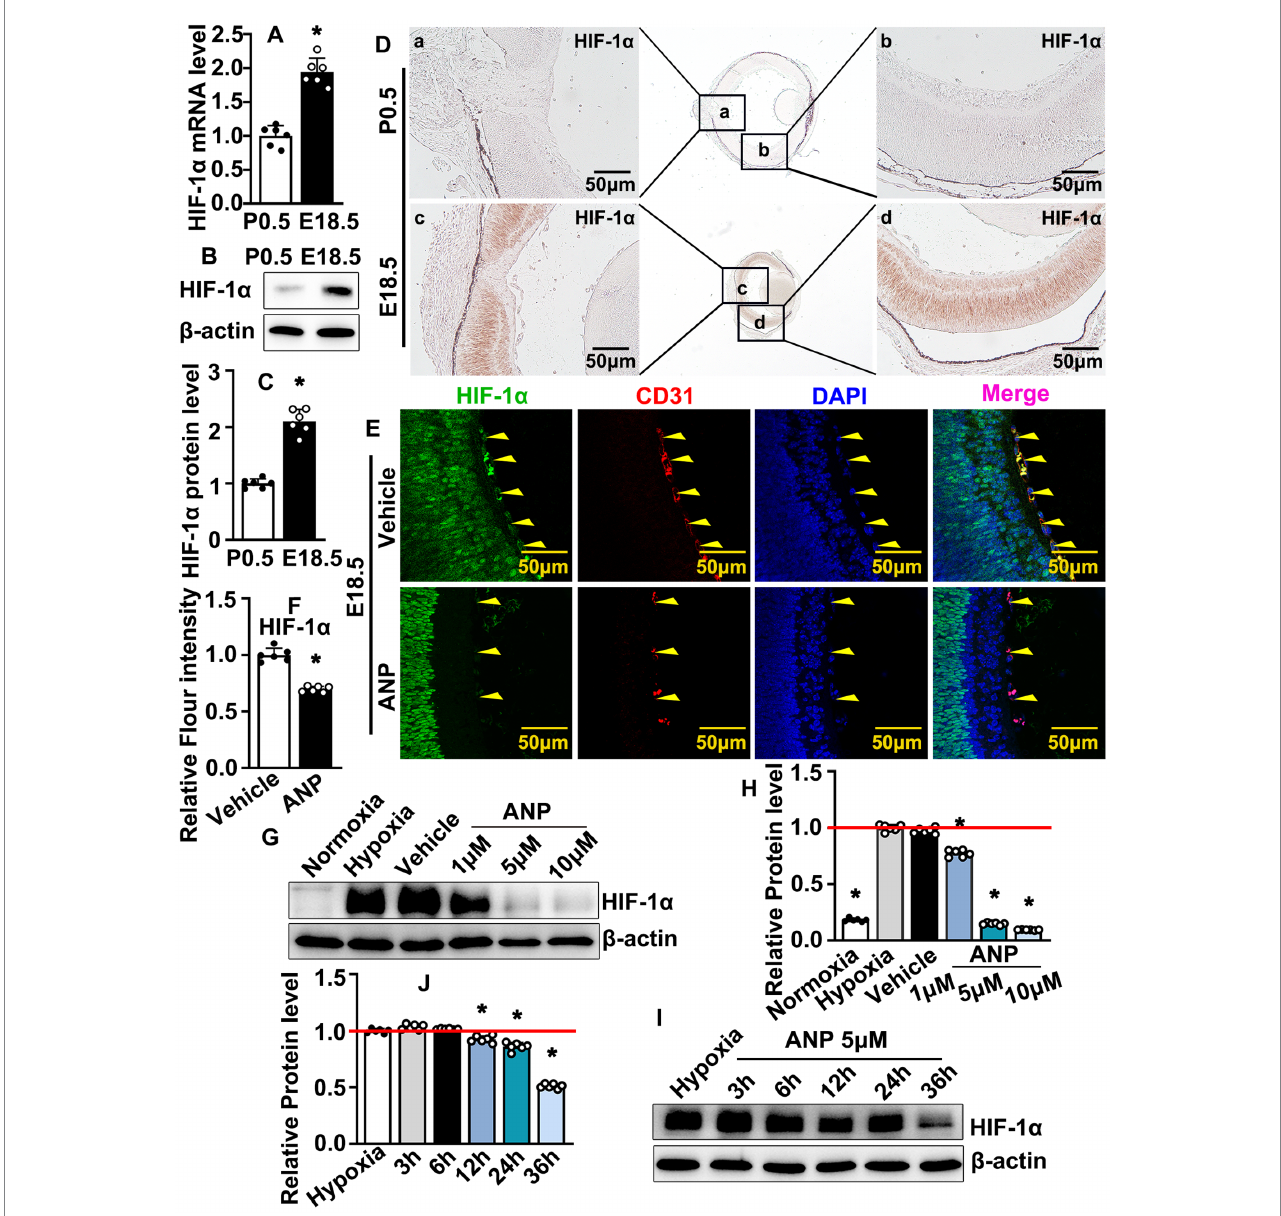
FIGURE 4 Andrographolide inhibits embryonic hyaloid vascular endothelial HIF-1a expression during murine hyaloid vasculature development. (A) Total RNA prepared from retinas at E18.5 and P0. Real-time PCR was performed to evaluate HIF-1a mRNA transcription levels at E18.5 and P0.5 ( n = 6). (B) Total protein prepared from retinas at E18.5 and P0.5. HIF-1a protein levels were determined by western blotting. Relative expression level of HIF-1a was exhibited in (C) ( n = 6). (D) IHC staining against HIF-1a antibody performed on slides from P0.5 and E18.5 to determine expression of HIF-1a. Whole images were exhibited in the middle sites and the high resolution images of the corresponding areas were displayed on both sides. (E) Immunofluorescence staining against HIF-1a and CD31 antibodies were performed to evaluate HIF1a expression in hyaloid vascular endothelial at E18.5 following andrographolide (10 mg/kg) consecutive treatment. (F) Relative expression of HIF-1a in hyaloid vascular endothelial at E18.5 following andrographolide treatment was quantified ( n = 6). (G) Hypoxia conditions were induced in HUVEC-C by 200 μ M CoCl 2 treatment, following different doses of andrographolide treatment (1 μ M, 5 μ M and 10 μ M). The expression levels of HIF-1a were determined by western blotting. (H) The quantification of relative HIF-1a protein levels following different doses of andrographolide treatment ( n = 6). (I) Hypoxia conditions were induced in HUVEC-C by 200 μ M CoCl 2 treatment. HUVEC-C was treated with 5 μ M andrographolide. Protein was harvested at different time points (3 h, 6 h, 12 h, 24 h, and 36 h) and western blotting was performed to determine HIF-1a expression. (J) The quantification of relative HIF-1a expression following andrographolide treated for different time points ( n = 6). Quantitative data are presented as mean ± SEM, * p <